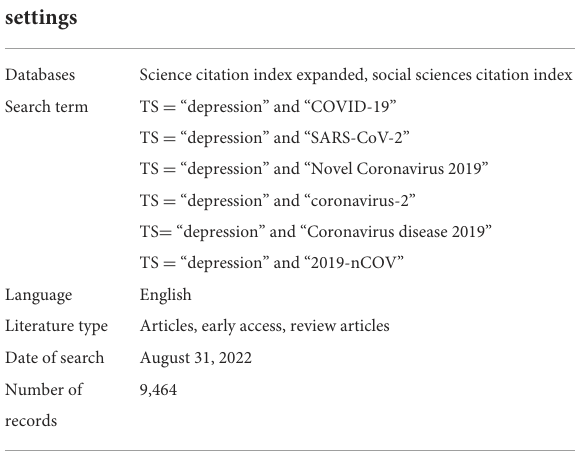
TABLE 1 Summary of data source and